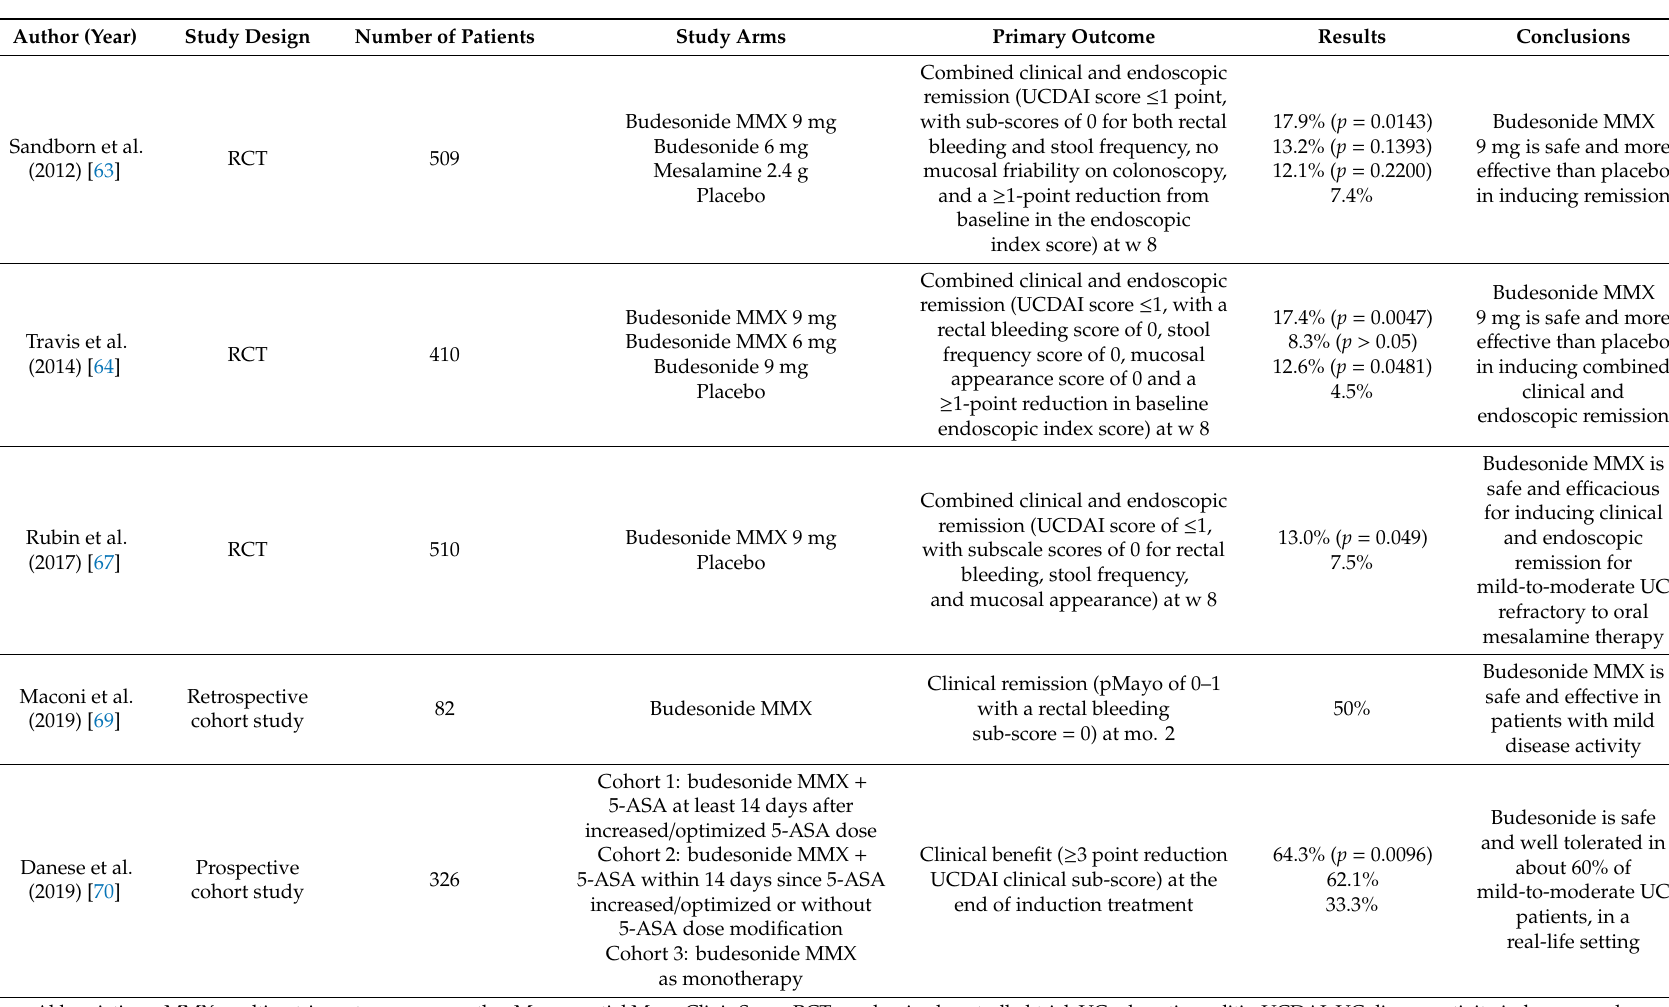
Table 2. Studies reporting the e ffi cacy of budesonide multimatrix system (MMX) in patients with mild-to-moderate ulcerative